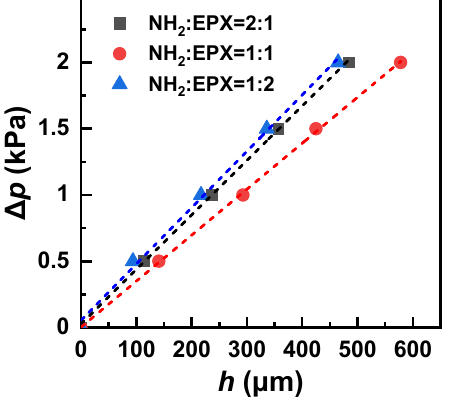
Figure 6. ∆ p vs. h plots for the PEG membranes prepared at the different mixing ratios of the STAR-NH 2 and STAR-EPX precursors (see the legend); a nearly linear dependence is tentatively traced by the straight lines. The thicknesses of the membranes were close to 100 nm. The window diameter was 1 mm.